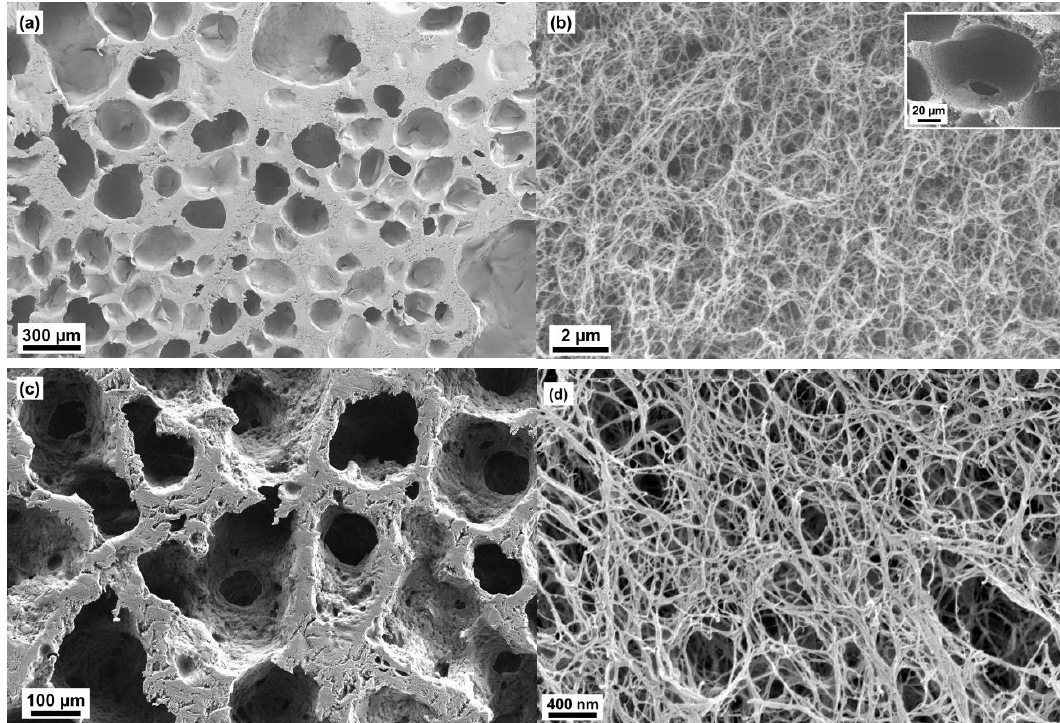
Figure 2. Scanning electron microscopic images of aerogels of cellulose scaffold (ACS)-PT13.5 (inset shows one of the neck part) ( a,b ) and ACS-PO15 ( c,d ).